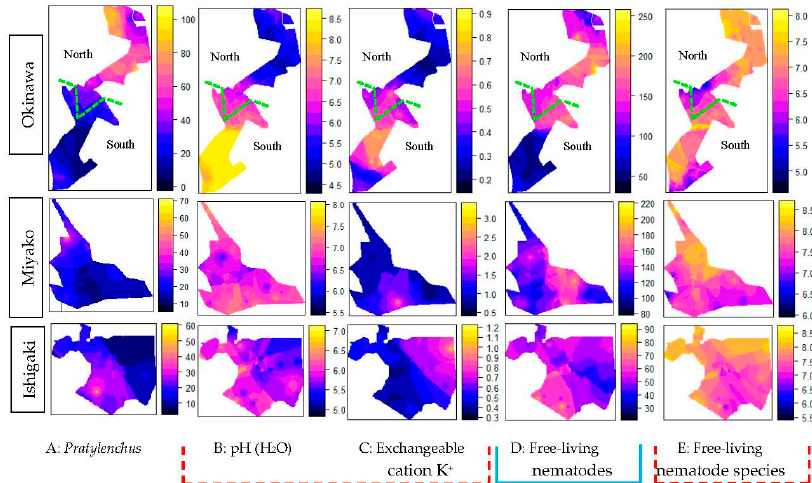
Figure 4. Spatial distribution of A: the abundance of Pratylenchus nematodes 20 g soil − 1 , B: pH (H 2 O), C: exchangeable cation K + (cmol kg − 1 ), D: the abundance of free-living nematodes 20 g soil − 1 , and E: the number of free-living nematode species in Okinawa, Miyako, and Ishigaki, predicted by the inverse distance weighting (IDW) approach. The green dotted line in Okinawa’s figure was to separate North and South regions. To the abundance of Pratylenchus in the mixed-effect model, the blue solid line at the bottom has a positive relationship, and the dotted red line has a negative relationship.